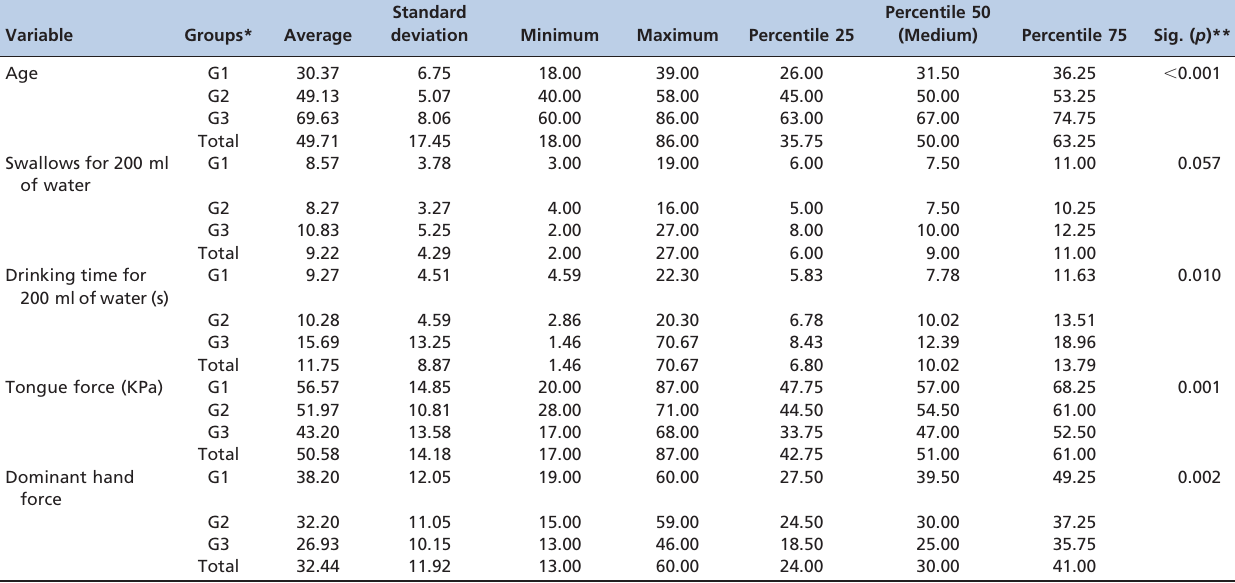
Table 1 - Comparison of variables: age, number of swallows, drinking time, tongue force and grip strength among the three age groups*.